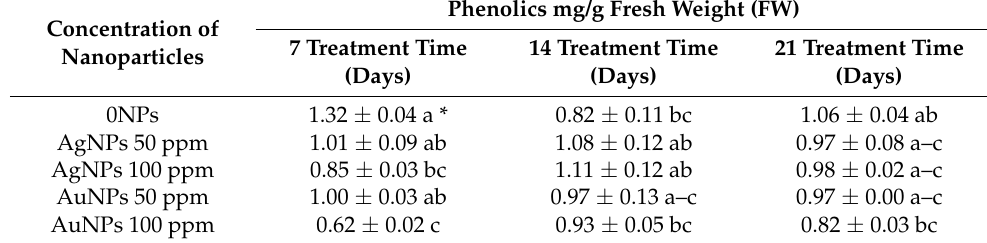
Table 4. Comparison of the influence of nanoparticles’ type and concentration on the free phenolics content in rapeseed